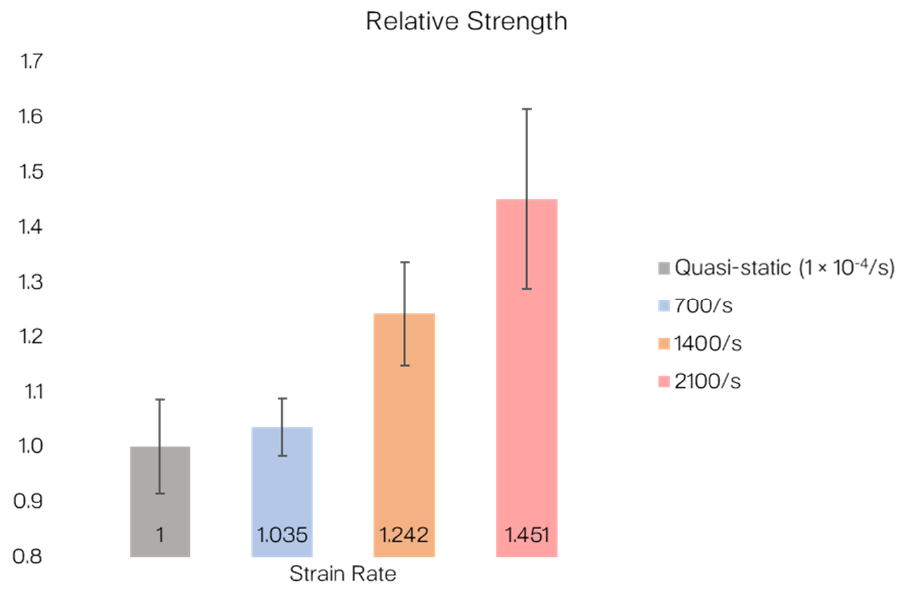
Figure 12. Quasi-static tensile strength of T700/PA6.6 versus dynamic tensile strengths (normalized to the quasi-static tensile strength).